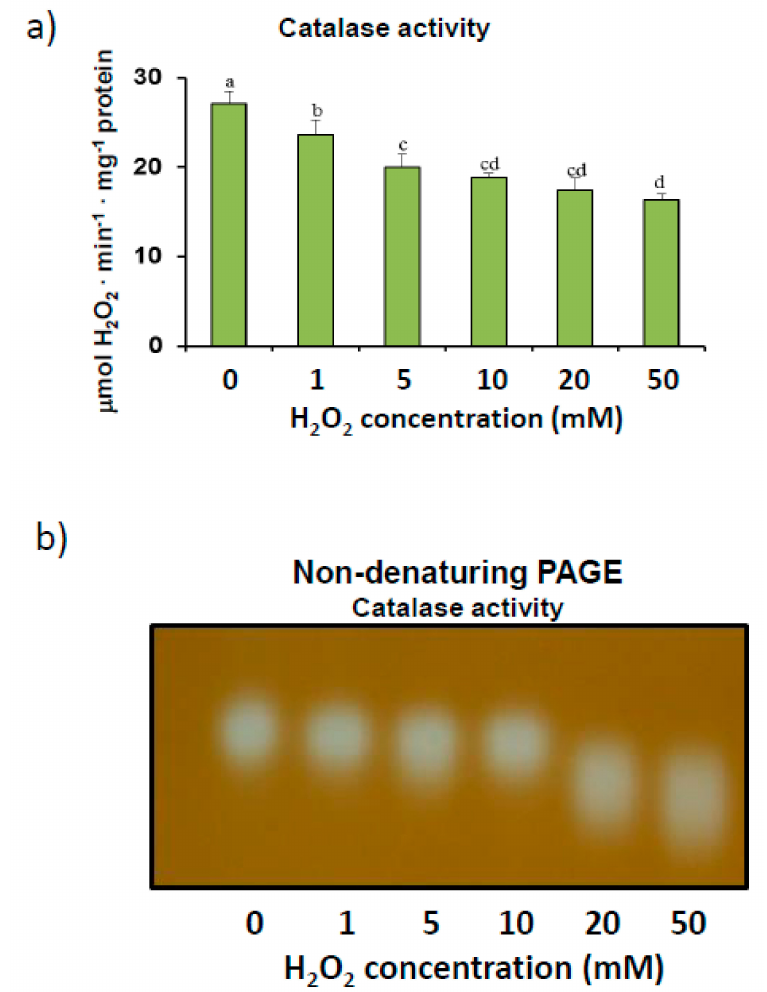
Figure 2. H 2 O 2 modulation of catalase activity in sweet pepper fruits. ( a ) Total activity. Crude extracts from green peppers were incubated in the presence of 0 to 50 mM H 2 O 2 for 30 min to determine catalase activity. Results are means ± SEM of samples from at least three di ff erent experiments. Columns with di ff erent letters are statistically distinct (ANOVA, p < 0.05). ( b ) Native PAGE (6% acrylamide) and catalase activity staining. Pepper fruit samples (20 µ g) were treated with H 2 O 2 (0–50 mM) for 30 min and then loaded onto gels. The shown picture is representative of the non-denaturing assays from at least three independent